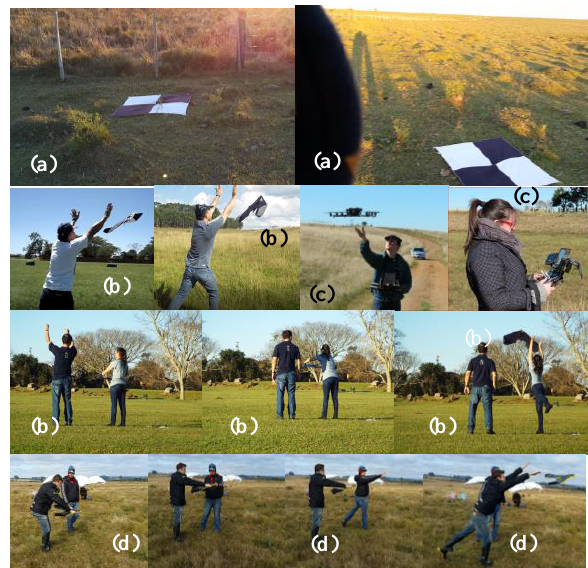
Figure 7. Distribution of pre-signaling of control points and photogrammetric flight; with the Professor teaching students: